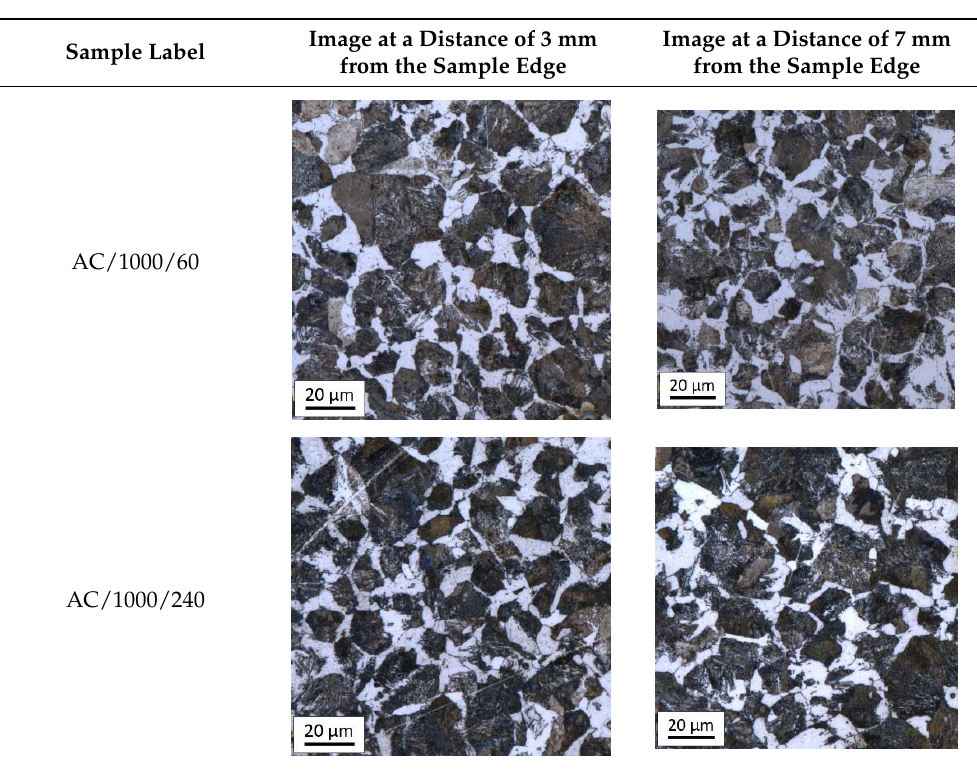
Table 8. Microstructure of steel after heating at 1000 °C for 60 min and 240 min with air-cooling.